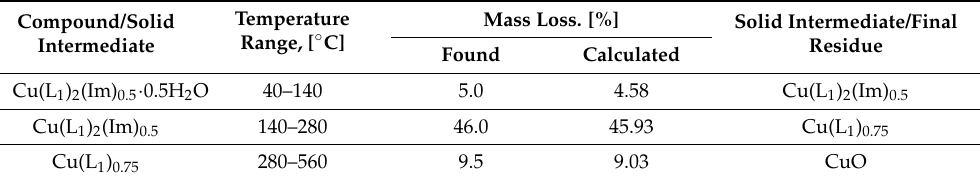
Table 6. TG-DTG analysis data of decomposition of Cu(L 1 ) 2 (Im) 0.5 · 0.5H 2 O.